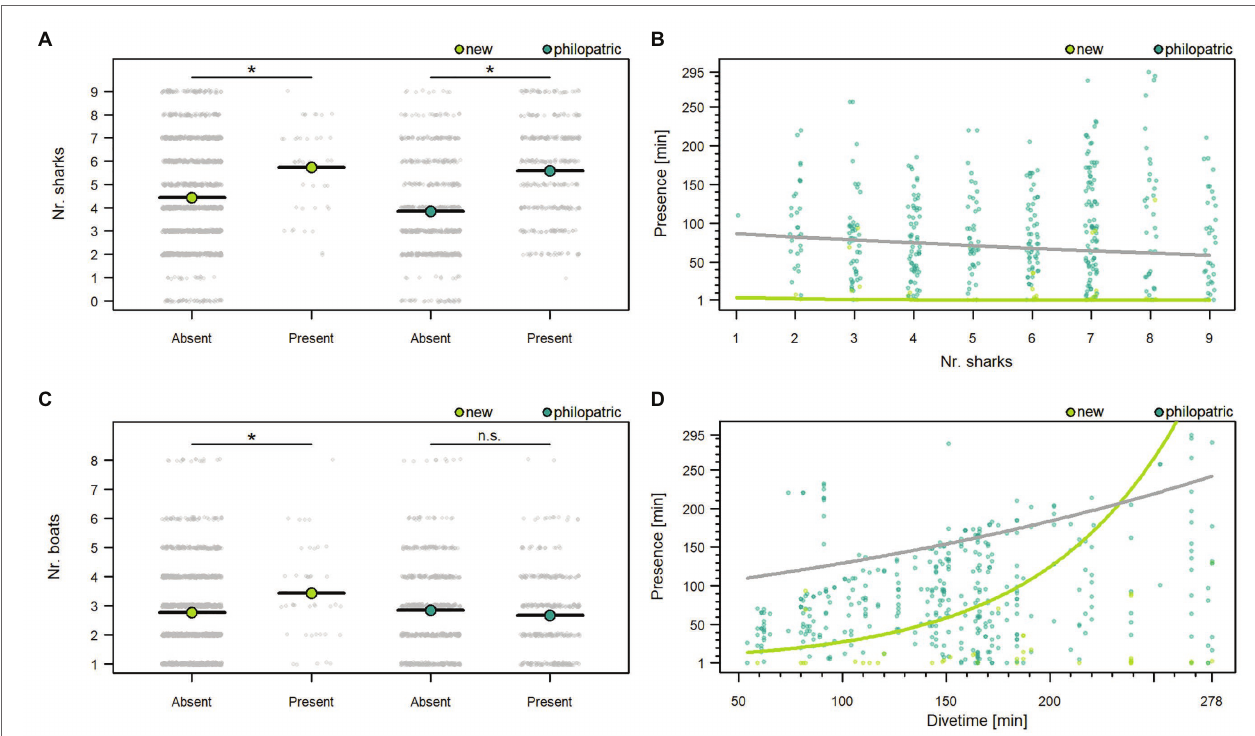
FIGURE 3 | Effects of the number of sharks on the presence (A) and presence time (B) , the number boats on the presence (C) , and the dive time on the presence time (D) , of great hammerhead sharks ( S. mokarran ) during provisioning dives. Plots (A,C) show a graphical representation of the Zero-Inflated Poisson generalized linear mixed model (GLMM; model 3). The x -axis contains the absence vs. presence data of individuals and the original data points are shown in light gray. The predictor variable is on the y -axis. Mean values in plots (A,C) are represented by the black bar containing a colored dot. Significance of a fixed effect in plots (A,C) is represented by “*,” whereas “n.s.” denotes a non-significant effect. Plots (B,D) show the Poisson part of model 3. The x -axis contains the predictor variables, and the response variable is on the y -axis. Original data for each group of sharks are shown in different colors as an interaction was entered. For the ease of representation only presence time values >0 min have been included in plots (B,D) . Colored curves represent significant regressions extracted from model 3 ( Table 4 ). Significant interactions but non-significant effects are shown as gray curves. The plots that contain a graphical representation of the non-significant effects for model 3 can be found in Supplementary Figure 2